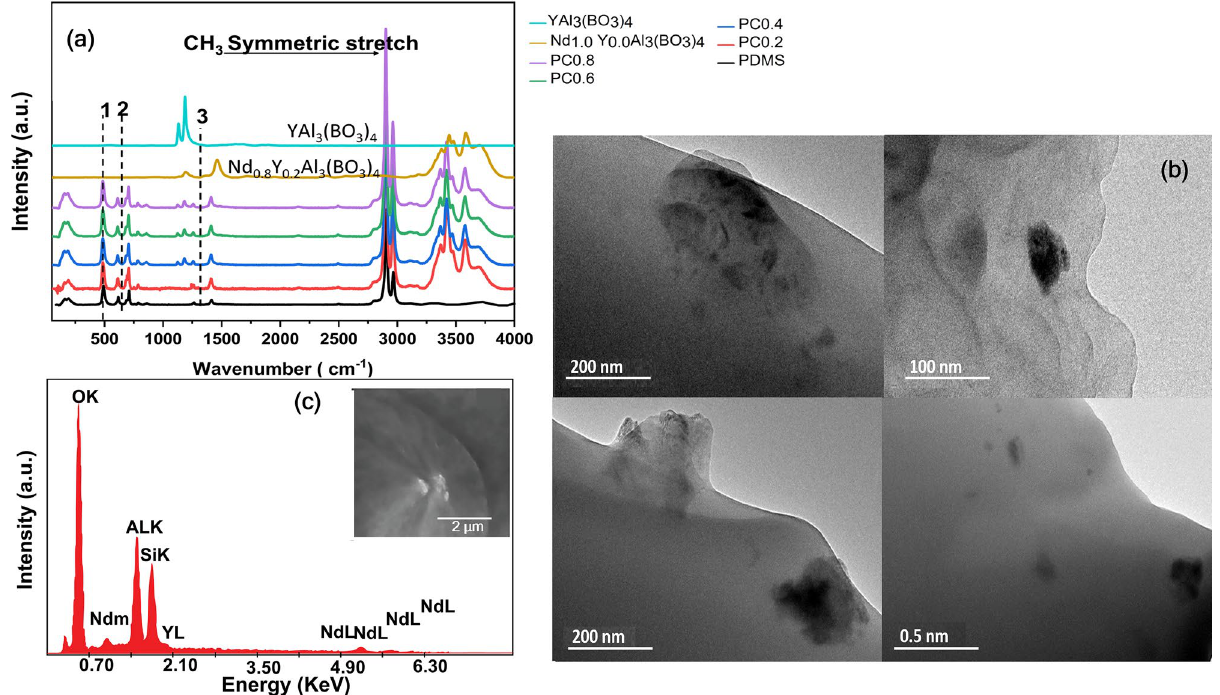
Figure 1. ( a ) Raman spectra of pristine PDMS (black curve) and PDMS nanocomposite with Nd x Y 1−x Al 3 (BO 3 ) 4 (PCx) with a 633 nm pump laser. Also shown are nanoparticles and YAl 3 (BO 3 ) 4 without PDMS (dark yellow and light blue lines respectively). Noted in the figures are (1) Si–O–Si Symmetric stretch peak at 487 cm −1 , (2) the Si– CH 3 symmetric rocking at 687 cm −1 , and (3) the Si–CH 3 symmetric bending 1260–1400 cm −1 , ( b ) TEM Images of PDMS composites with ultrafine particle incorporated with PDMS, ( c ) energy-dispersive X-ray analysis of PC0.8. The inset shows an SEM image of the sample with 5 µm scale.